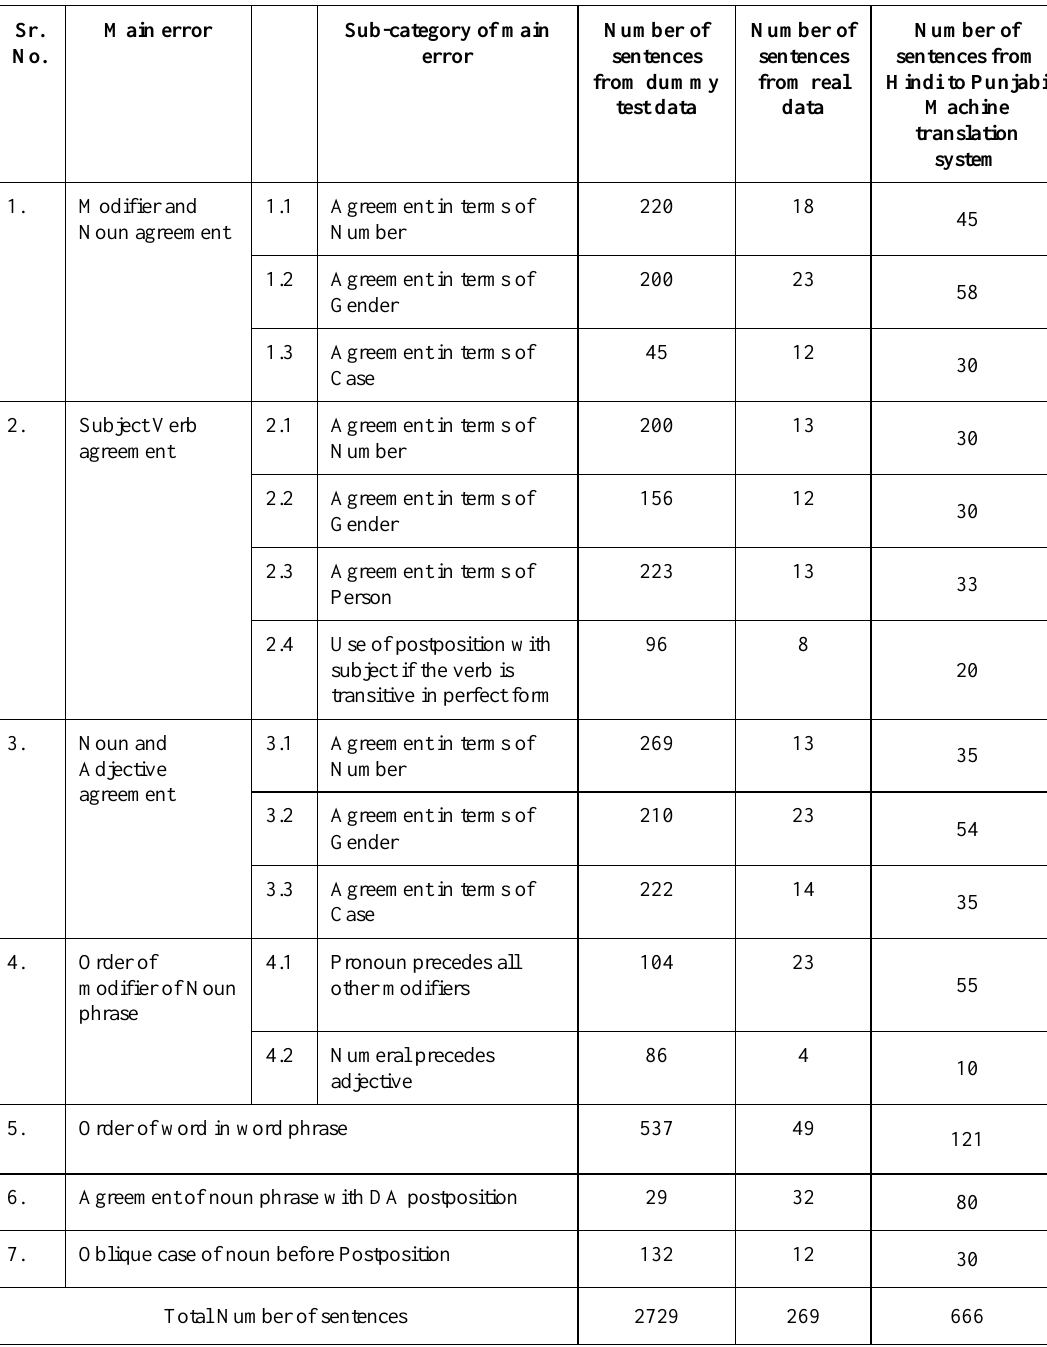
Table 2: Test data used to test various types of